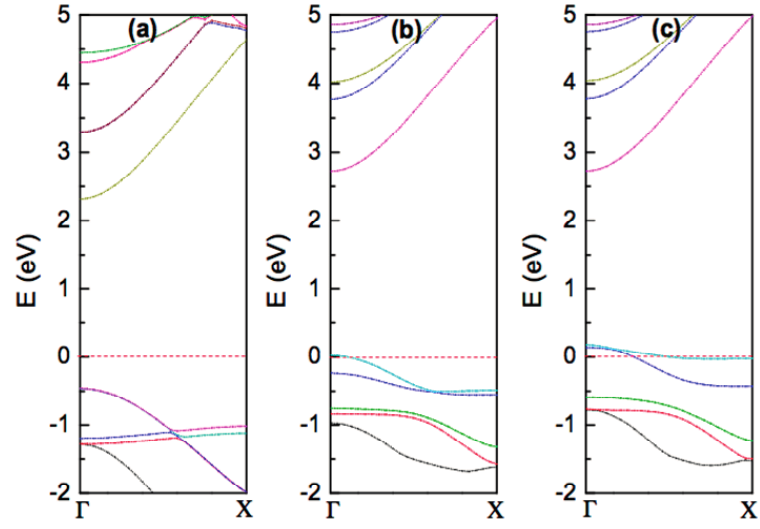
Figure 9. Electronic band structure of ( a ) pristine (6, 0) BNNT, ( b ) fluorinated (6, 0) BNNT (spin up states), and ( c ) fluorinated (6, 0) BNNT (spin down states); the Fermi-energy is set to zero. The partially filled bands near the Fermi-energy in the case of fluorinated BNNT have small dispersion as the fluorine atom acts as a shallow acceptor upon adsorption on BNNT. Band structures results presented here are obtained using density functional theory; the generalized gradient approximation (GGA) with the PW91 functional for the exchange-correlation is used. The projected augmented wave (PAW) approach is used to describe the valence-core